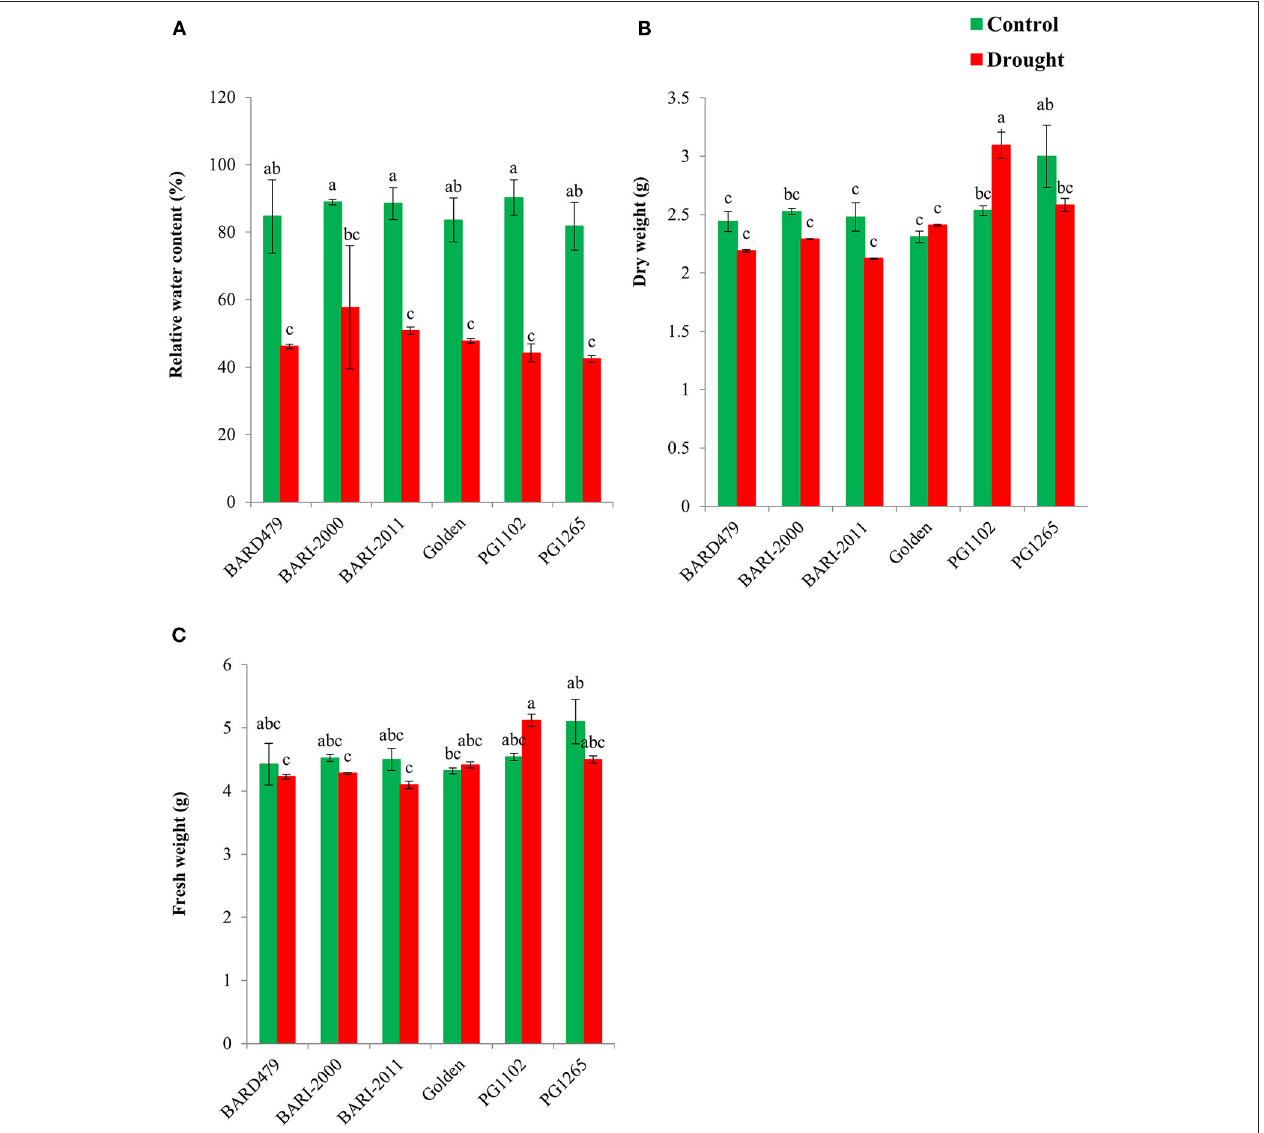
FIGURE 2 | Water status and biomass of genotypes of peanut under drought stress. The panel shows the following: the relative water content (RWC) (A) , the dry weight (DW) (B) , and the fresh weight (FW) (C) . Data are shown as the interaction between the genotypes of peanut and the drought applied. Significance was inferred either with an ANOVA under the Tukey’s HSD post-hoc test for normally distributed data (Honest Significant Detection, p < 0.05). Non-parametric data were analyzed with a Kruskal–Wallis test under False Discovery Rate post-hoc correction (FDR, p <